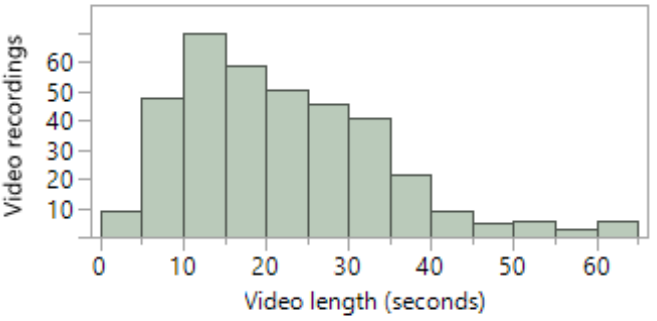
Figure 4. Distribution of videorecording lengths.